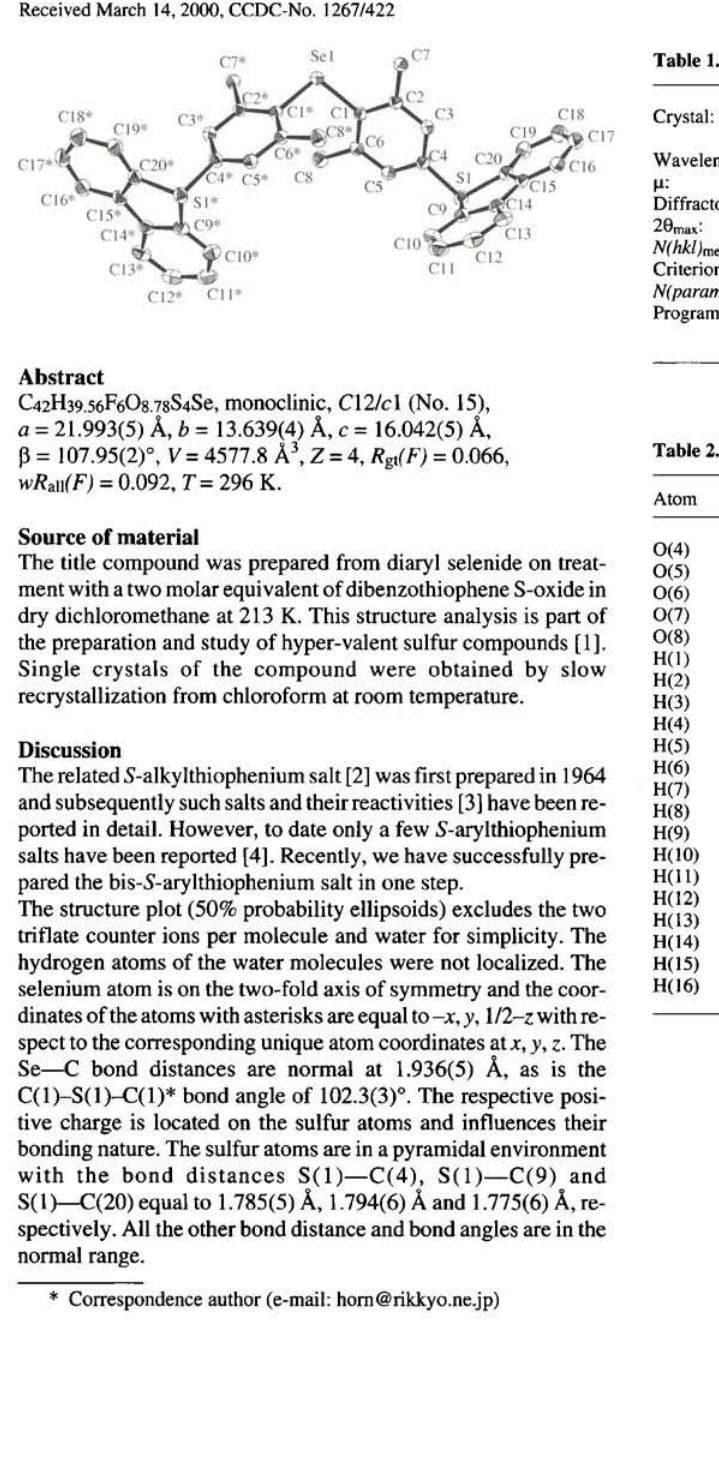
Table 1. Data collection and handling.